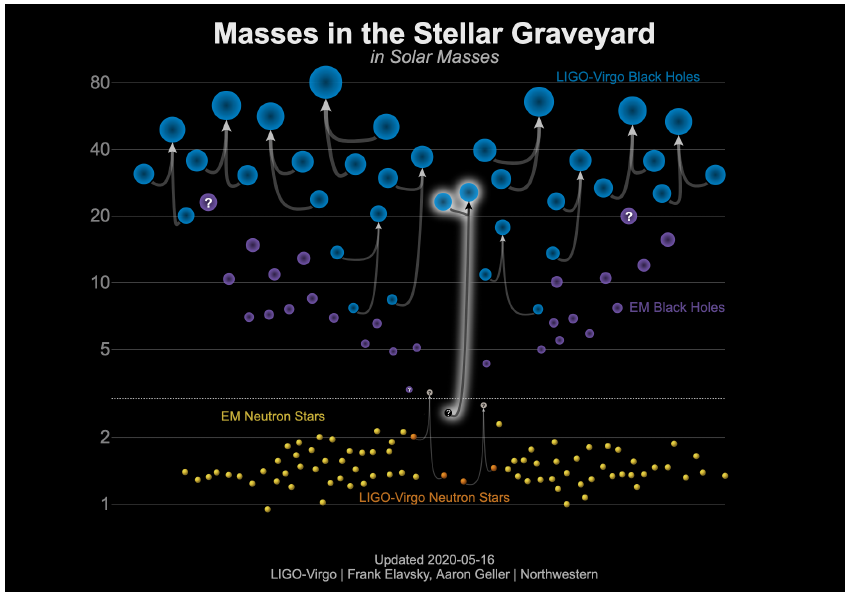
Figure 4. Masses of LIGO/Virgo discoveries. The network of detectors has observed the merger of different compact binaries. The BHs represent a diverse population with larger masses than what had been witnessed before, solely with X-ray observations. This plot shows the masses of the binary components before the merger and the mass of the postmerger object. [Image credit: LIGO-Virgo/Northwestern Univ./Frank